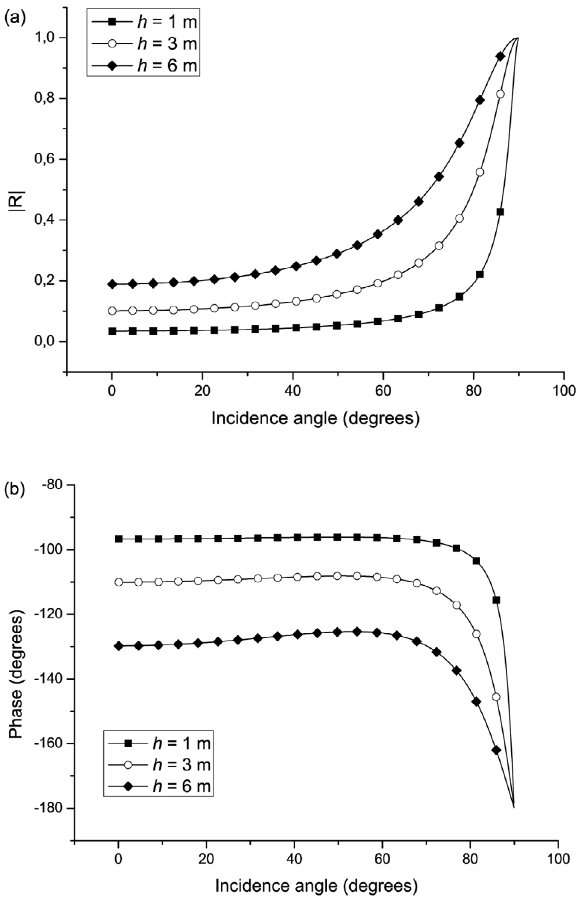
Figure 7. Vein of quartz in limestone. Absolute value (a) and phase (b) of the TM-wave reflection coefficient as a function of the inci- dence angle and three values of h